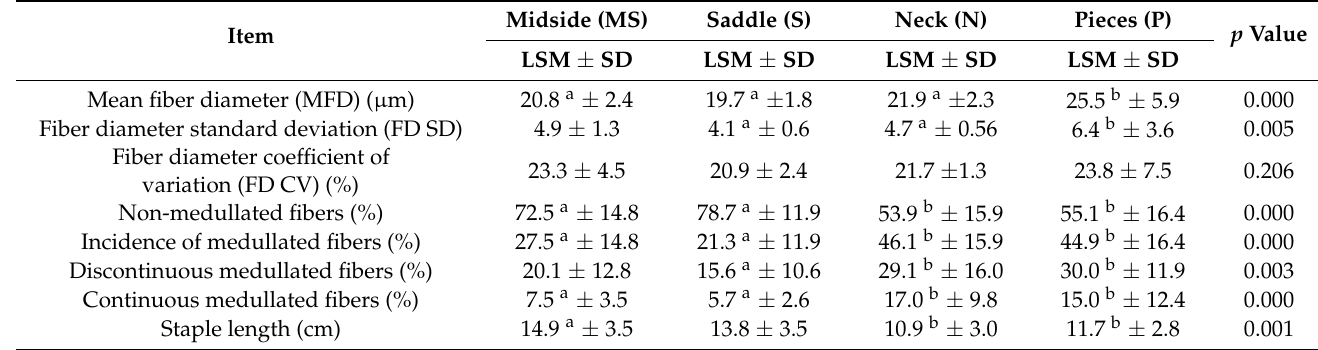
Table 2. Wool quality attributes for the different body